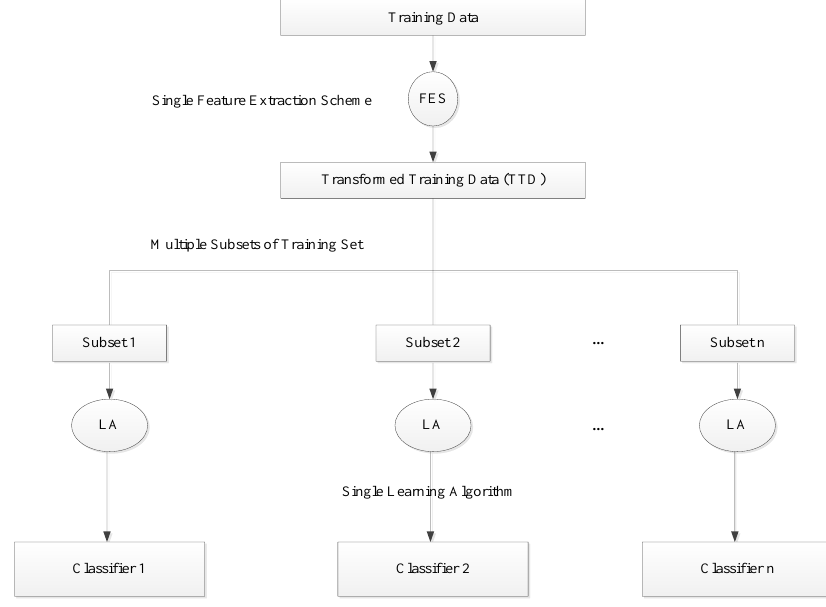
Figure 2. Homogeneous paradigm.